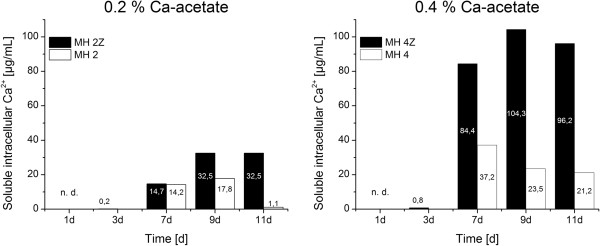
Soluble intracellular calcium concentrations in media with 0.2% (left) and 0.4% (right) Ca-acetate concentrations. The soluble intracellular calcium levels showed a dependency of the presence of zinc in the medium. Bacteria cells accumulated calcium to higher levels in medium with zinc acetate (MH 2Z and MH 4Z) compared to media without elevated zinc concentrations (MH 2 and MH 4). Concentrations of calcium are indicated in the columns in μg/mL. The concentration of calcium at day 1 was not determined (n.d.) due to cell density limitations.